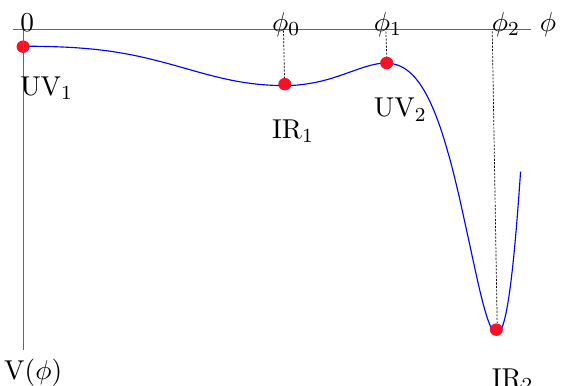
Figure 5 . Plot of the degree-12 potential which allows skipping solutions. This potential has several extrema which are denoted as UV 1 , UV 2 , IR 1 and IR 2